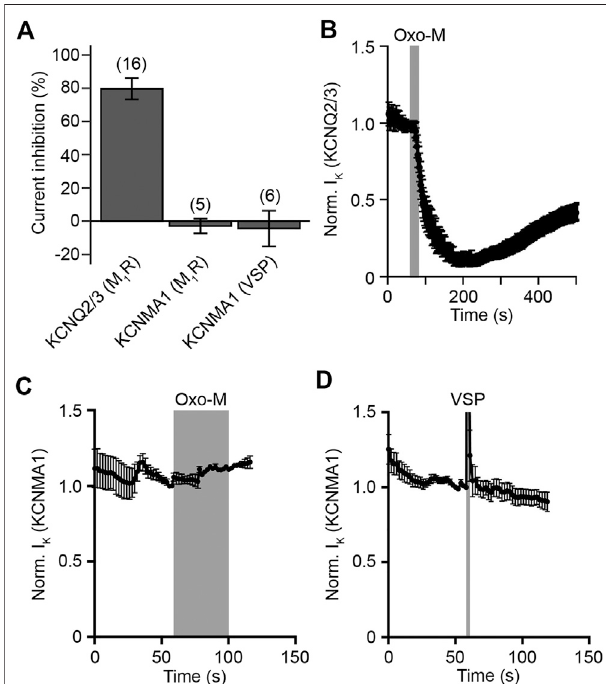
FIGURE 2 | Electrophysiological characterization of PI(4,5)P2- dependence of KCNMA1 channel α -subunits. (A) . Current inhibition of KCNQ2/3 or KCNMA1 channels in response to activation of M 1 R or Dr-VSP. Numbersinbracketsindicatenumberofexperiments.Errorbarsindicate SEM. (B) . Normalized KCNQ2/3-mediated current in HEK293 cells in response to stimulation of expressed mouse muscarinic acetylcholine receptors type 1 for 20 s with 10 μ M Oxo-M ( n (cid:2) 16, error bars indicate SEM). Traceswerenormalizedtothelasttimepointbeforeapplication ofOxo-M. (C) . Normalized KCNMA1 channel α -subunit-mediated current in HEK293 cells in response to stimulation of expressed muscarinic acetylcholine receptors type 1 for 40 s with 10 μ M Oxo-M ( n (cid:2) 5, error bars indicate SEM). Traces were normalized to the last timepoint before application of Oxo-M. (D) . Normalized current recorded from HEK293 cells transiently transfected with Dr-VSP and KCNMA1 channel α -subunits ( n (cid:2) 6, error bars indicate SEM). Grey bar indicates time of depolarization to 100 mV to activate Dr-VSP. Traces were normalized to the last timepoint before activation of Dr-VSP.